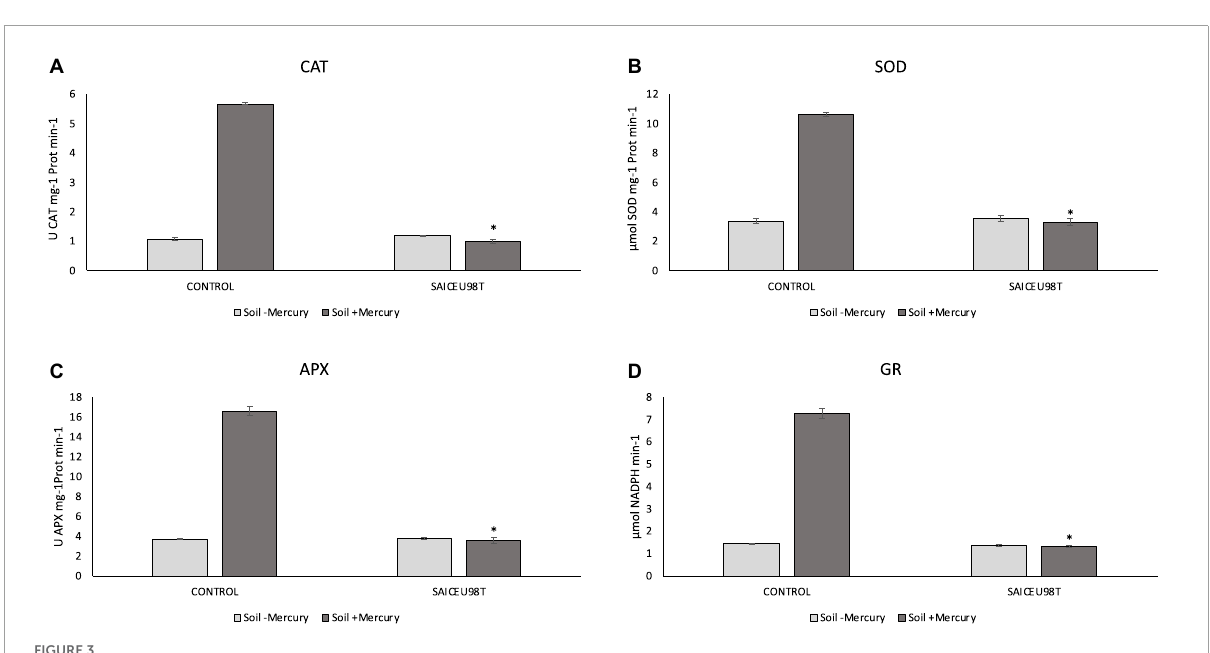
promoted a significant decrease in the accumulation of mercury in the shoot of the plant, respect the